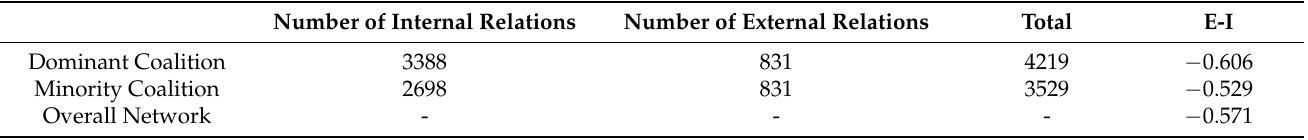
Table 5. E-I index of networks